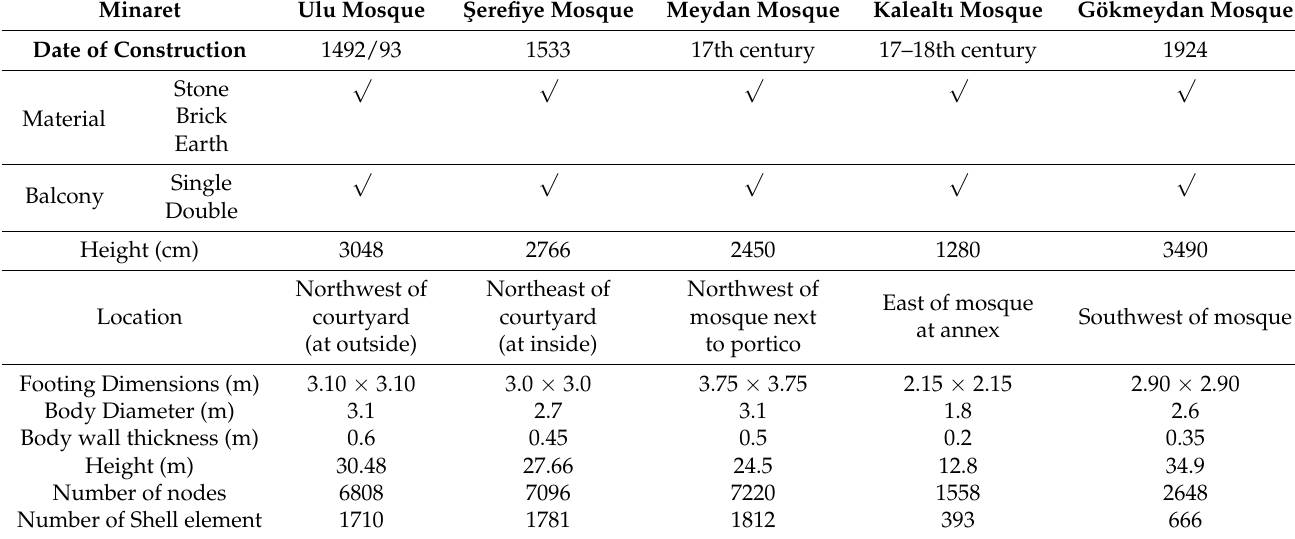
Table 4. Characteristics and structural model properties of Five